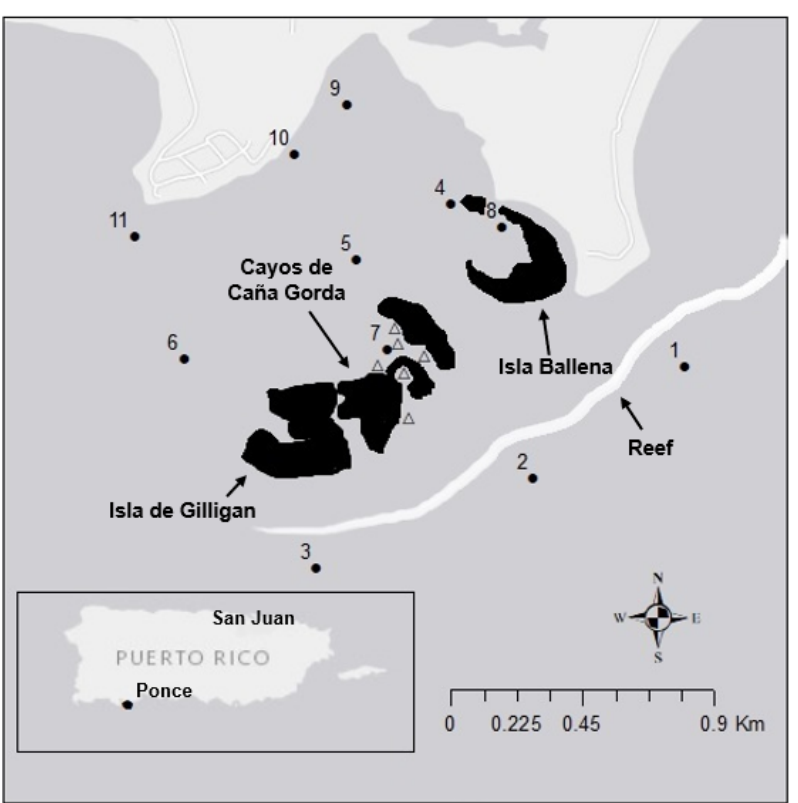
Figure 1. Map of study stations in the Guánica Biosphere Reserve located off the southwestern coast of Puerto Rico. POM and zooplankton were collected from the top portion of the water column (circles) at all 11 stations in the reserve. The MSP reef seascape (station 7) was sampled extensively for both primary producers and consumers. In addition, BMA (triangles) were collected from six stations within the MSP.